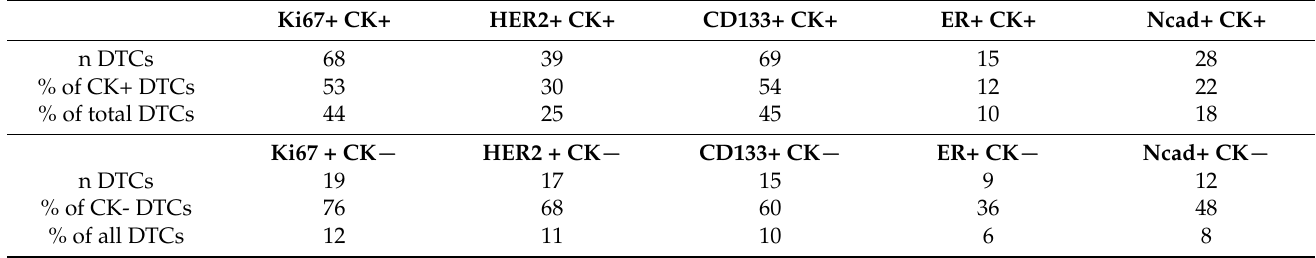
Table 4. Quantification of CK-positive and CK-negative DTC